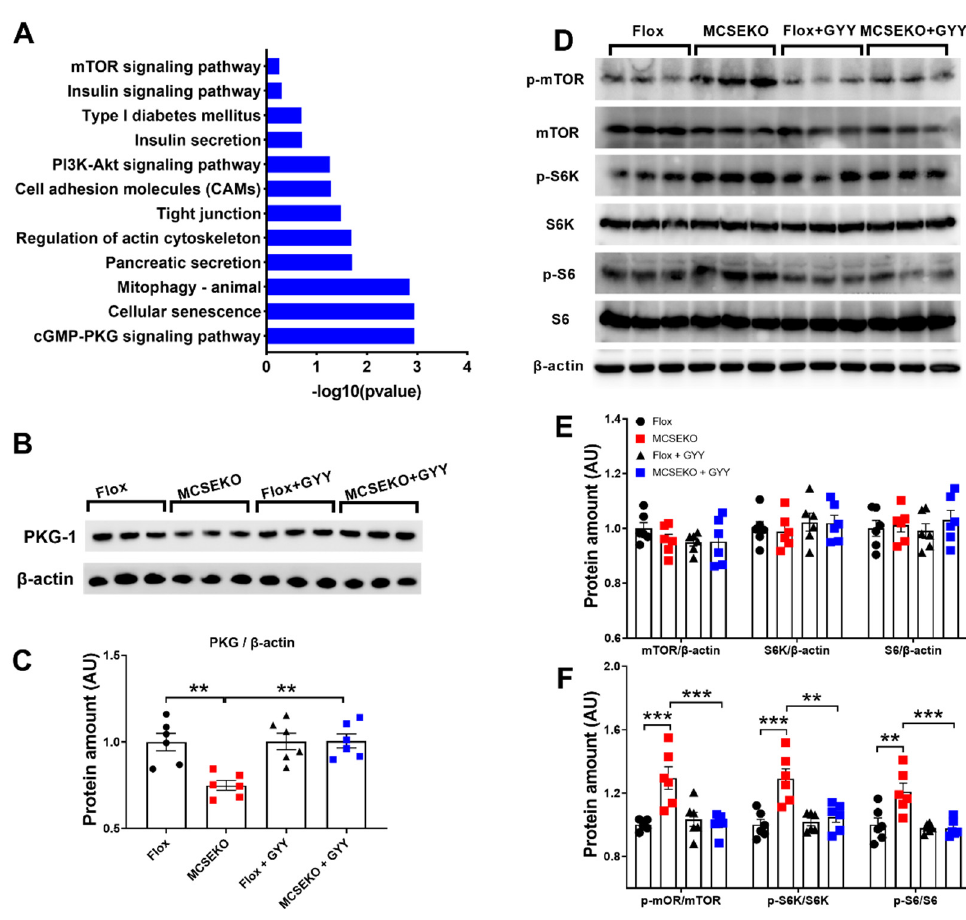
Figure 6. The PKG-1 level and mTOR signal pathway are altered in MCSEKO mice and GYY4137 treatment reverses them. MCSEKO mice and Flox mice were treated with GYY4137 or vehicle for six weeks. Western blot analysis of PKG-1 and mTOR signal pathway in GAS muscle. ( A ) Enriched pathways of KEGG analysis, ( B ) The representative images of western blotting of PKG1. ( C ) Cumulative data of western blotting images of PKG-1. ( D ) The representative images of western blotting of mTOR signaling pathway. ( E , F ) Cumulative data of western blotting images of mTOR signaling pathway. Data were expressed as means ± SEM ( n = 6 in each group). ** p < 0.01,*** p < 0.001.